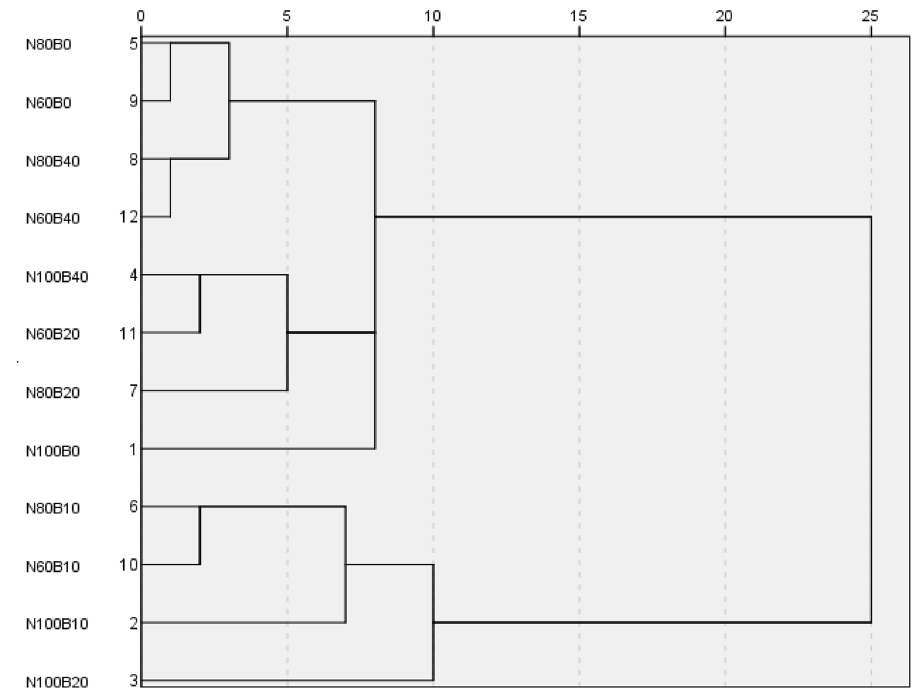
Figure 1. Cluster analysis of soil fertilization in each